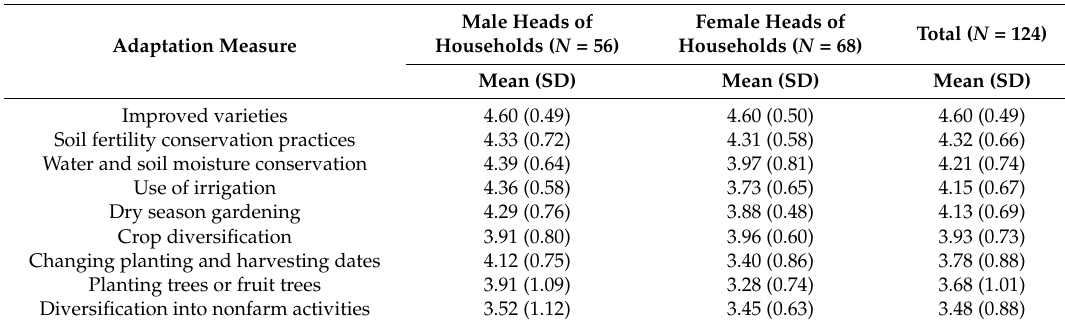
Table 3. Gender differences in perceptions of the effectiveness of adaptation